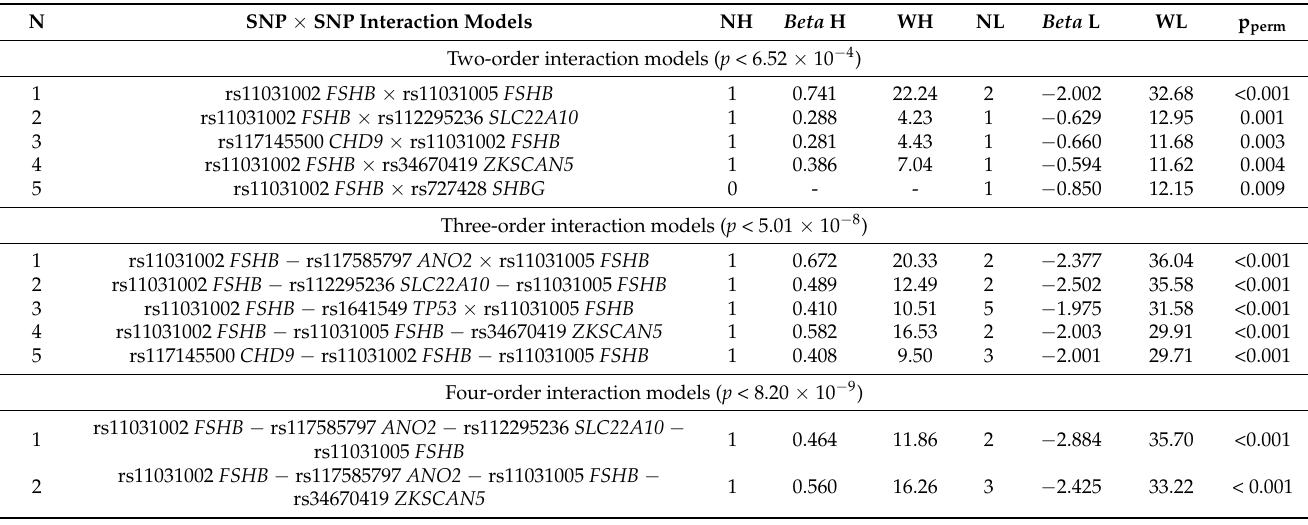
Table 3. SNP × SNP interactions significantly associated with